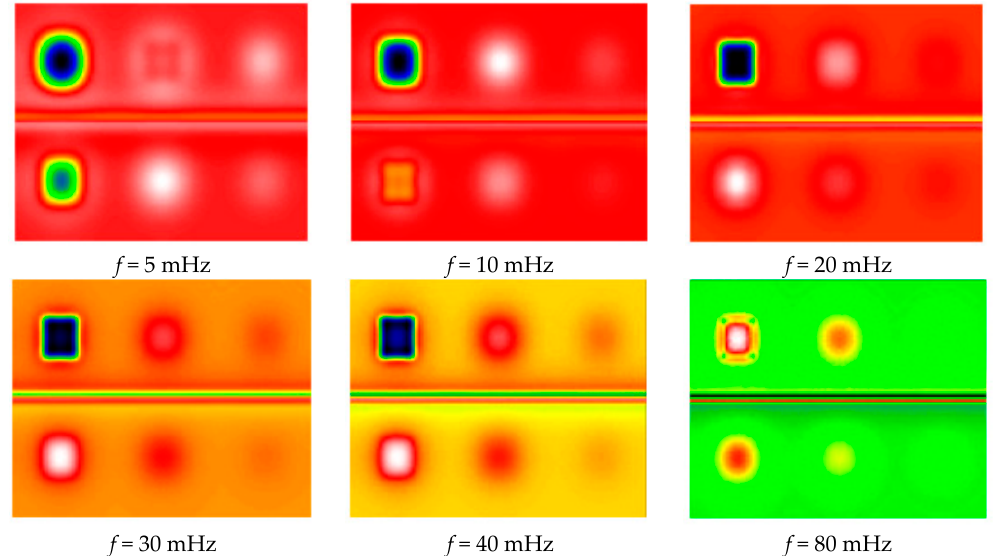
Figure 6. Phase images of the calculated harmonic response.